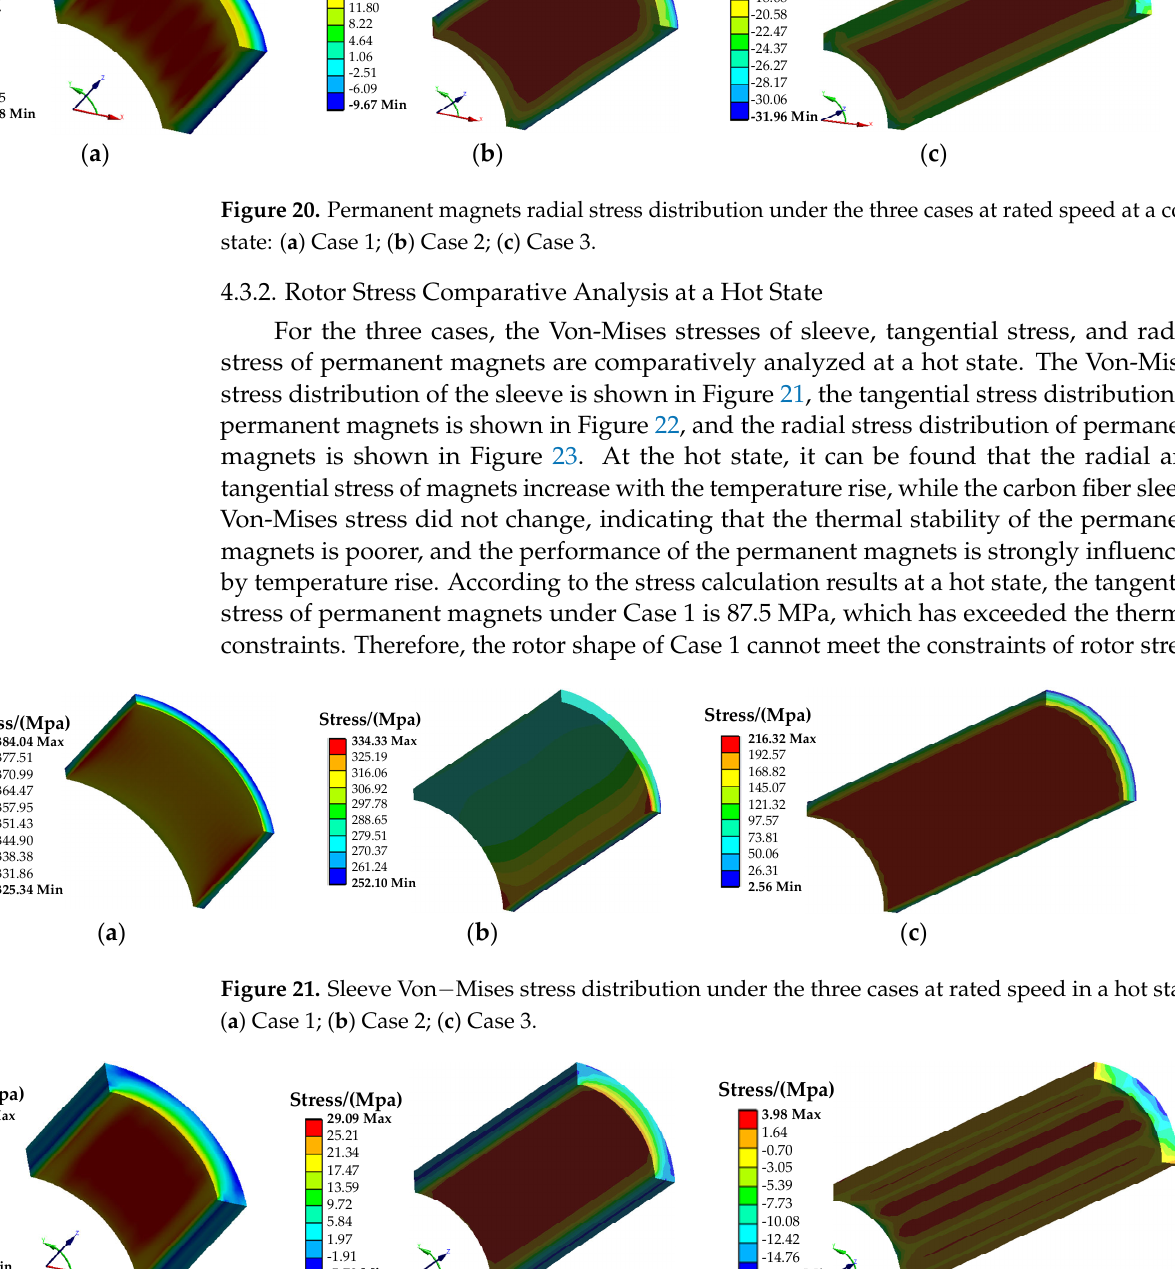
Stress/(Mpa) 33.05 Max 27.13